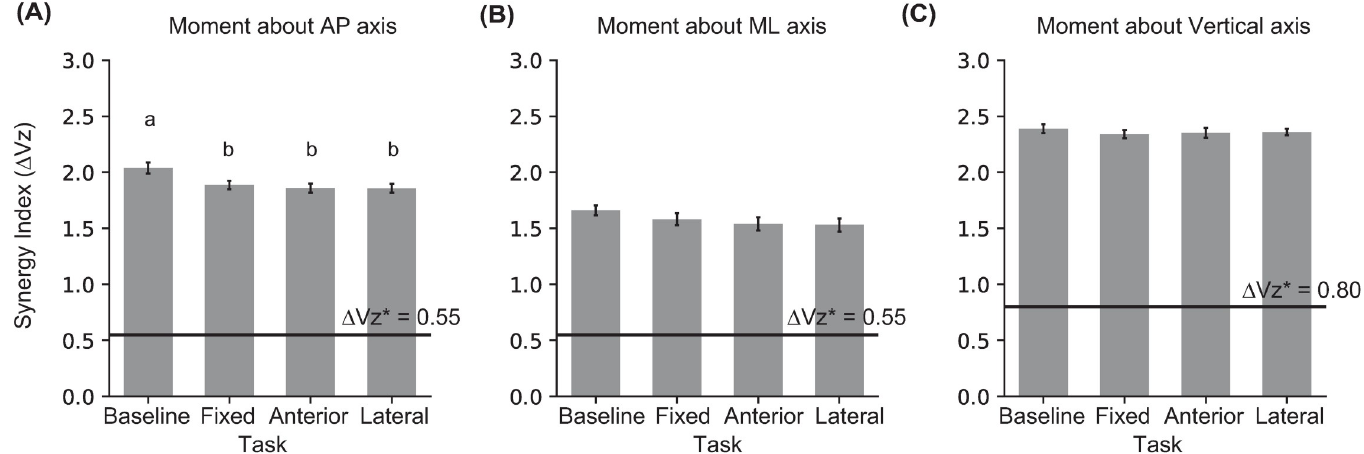
Fig 6. Mean and standard error for the synergy index ( Δ Vz) for stabilizing resultant moment about the (A) AP, (B) ML, and (C) vertical axes during the double support phase. The horizontal lines in each plot show the discriminating values for each synergy index. Δ Vz greater than the corresponding discriminating value indicates presence of synergy. Means with different letters are significantly different from one